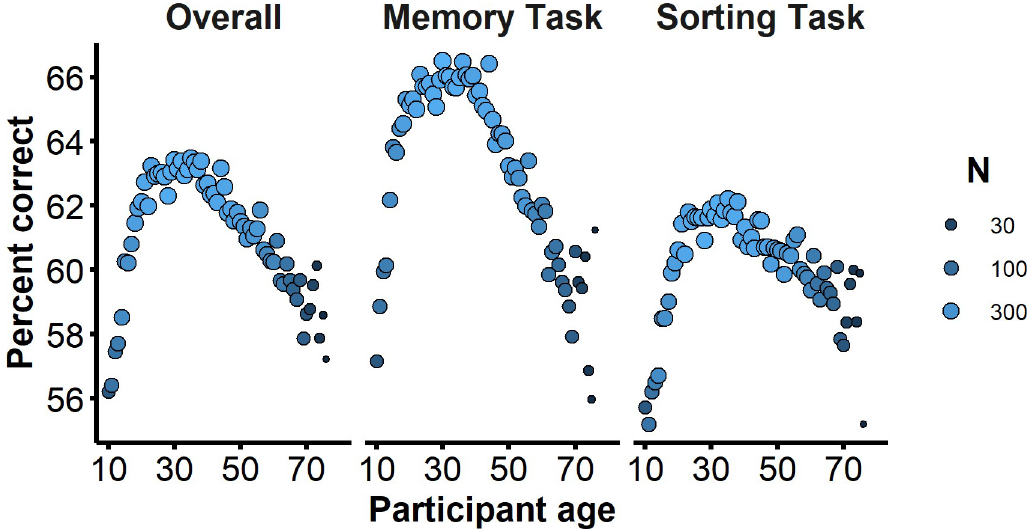
Fig 8. Average accuracy for each participant age on the UNSW Face Test separated for overall (left), memory task (middle) and sorting task (right). Size and shade of each data point show the number of participants in that age group.